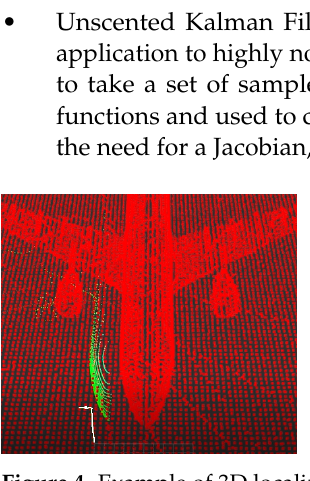
Figure 4. Example of 3D localization using nonlinear ICP algorithm (white), 3D laser Scan (green) and a 3D Occupancy grid map